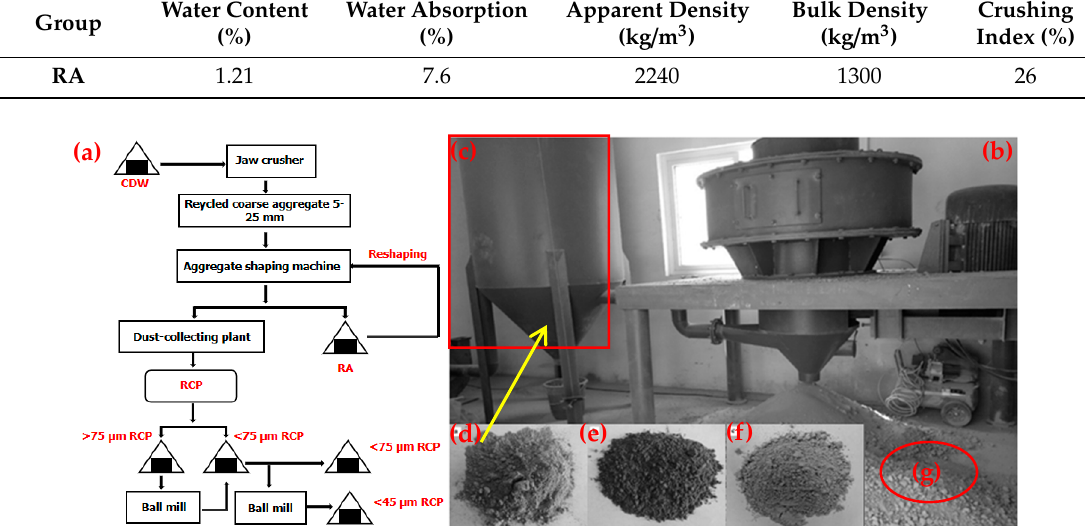
Table 1. The basic properties of recycled aggregate (RA).